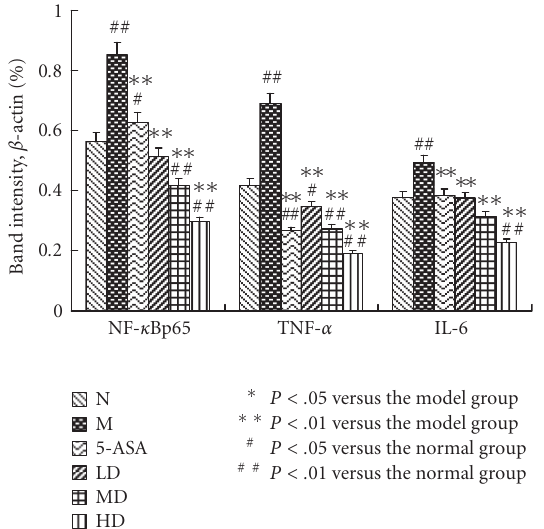
Figure 7: The mRNA expressions of TNF- α , NF- κ Bp65, and IL-6 were measured by average ratios of TNF- α /GAPDH, NF- κ Bp65/GAPDH, and IL-6/GAPDH, respectively. RT-PCR analysis showed increased TNF- α , NF- κ Bp65, and IL-6 mRNA levels in colon tissues of the M group; EGB could reduce the mRNA expres- sions dose dependently, which were consistent with the Western blot analysis. The results were expressed as means (cid:0)